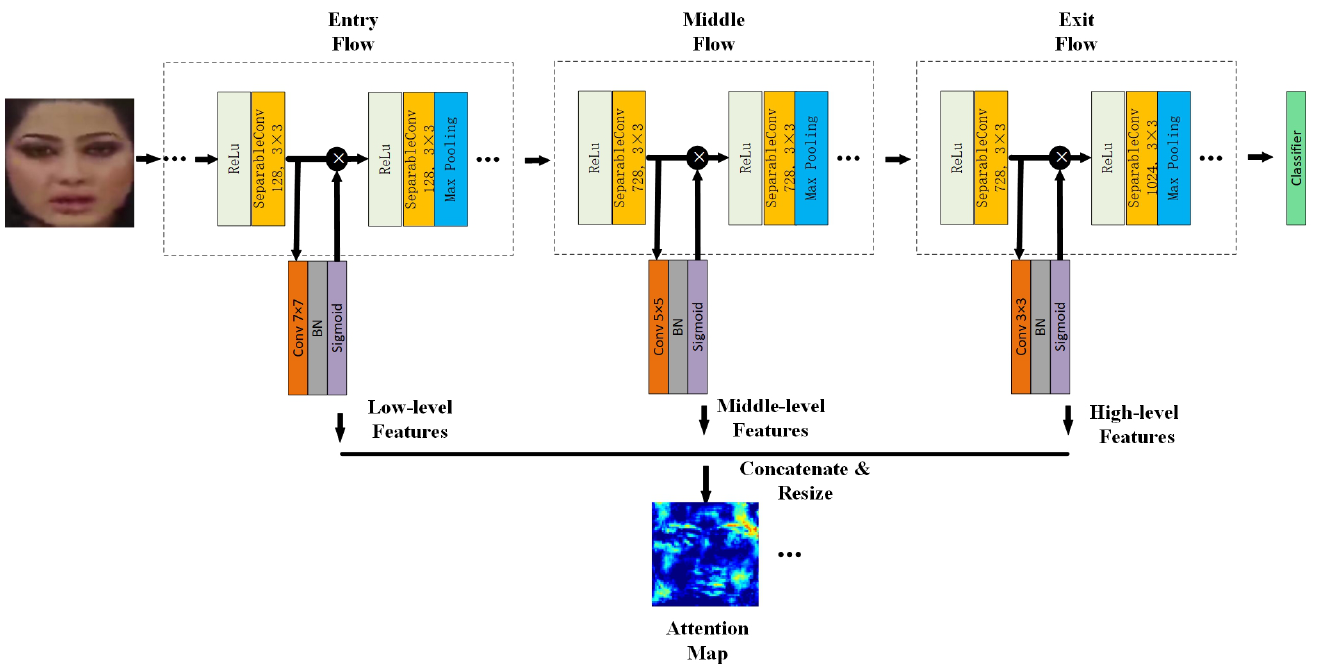
Figure 3. Supervised attention network